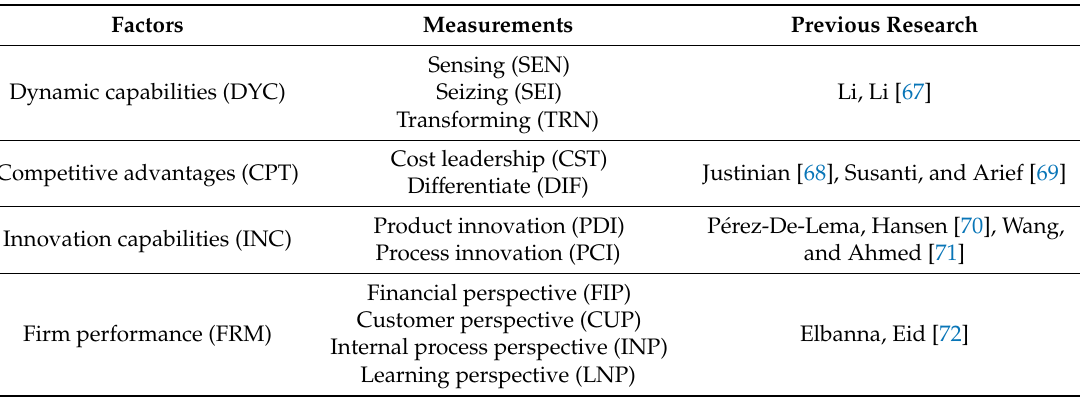
Table 1. Questionnaire factors and